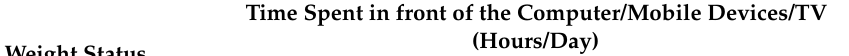
Table 7. Comparison of the body weight status and the hours spent in front of the computer/mobile devices/TV during the full COVID-19 curfew